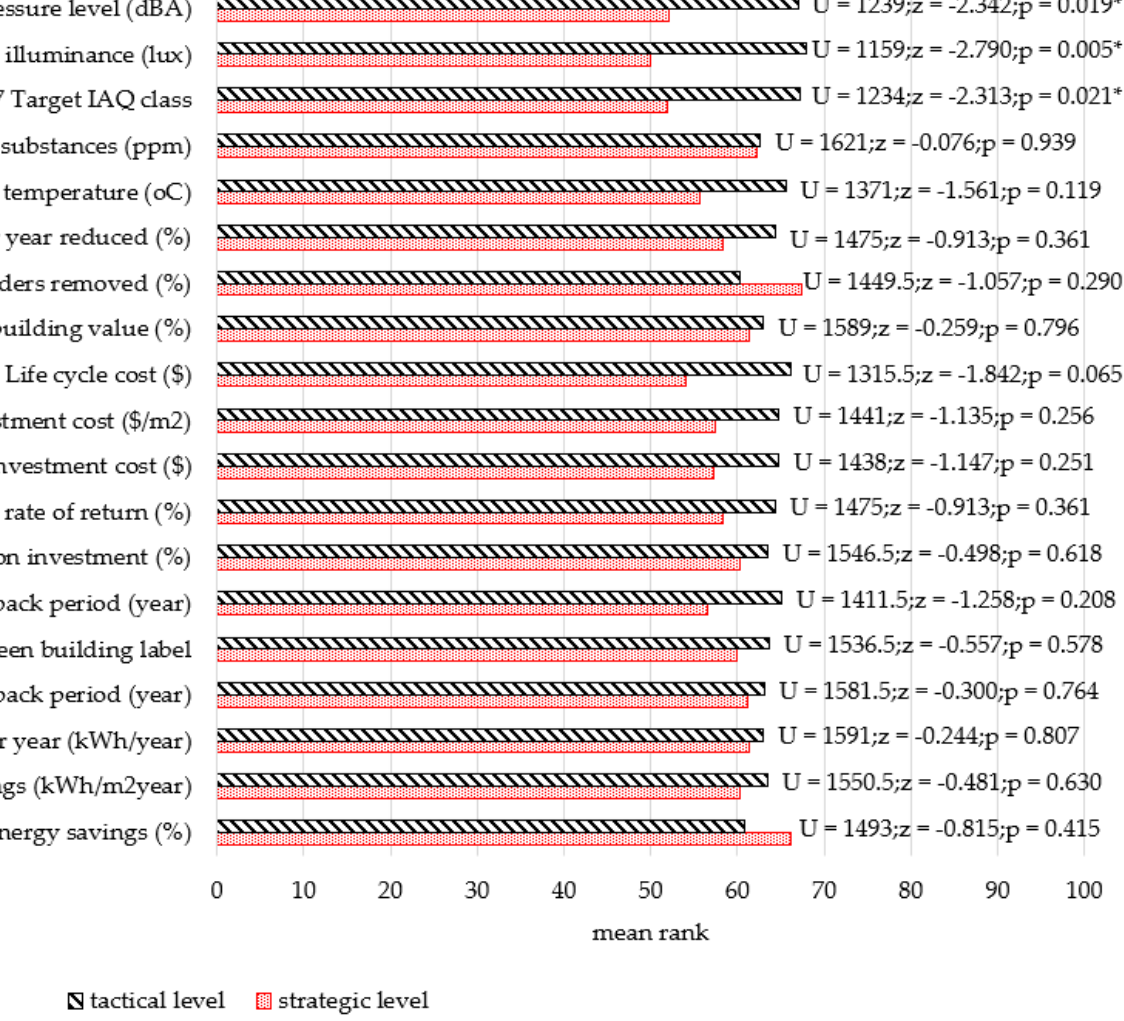
Figure A11. Mann – Whitney U-test results of G5 (job level). Figure A11. Mann–Whitney U-test results of G5 (job